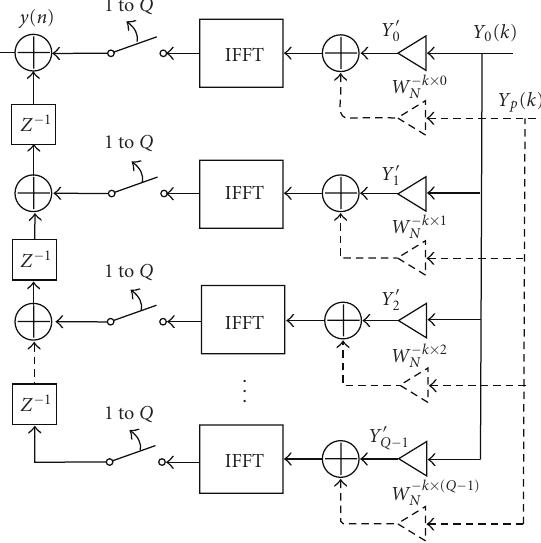
Figure 6: Structure of the proposed interpolation